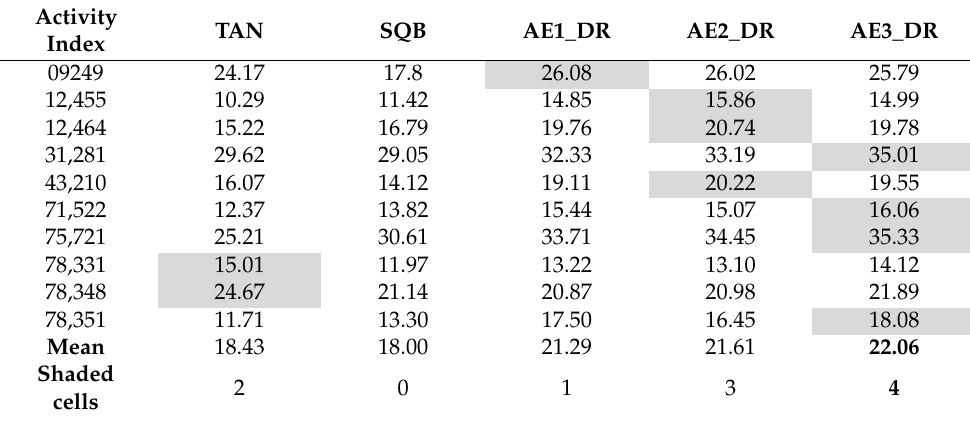
Table 9. The Retrieval results of top 5% for MDDR-DS3